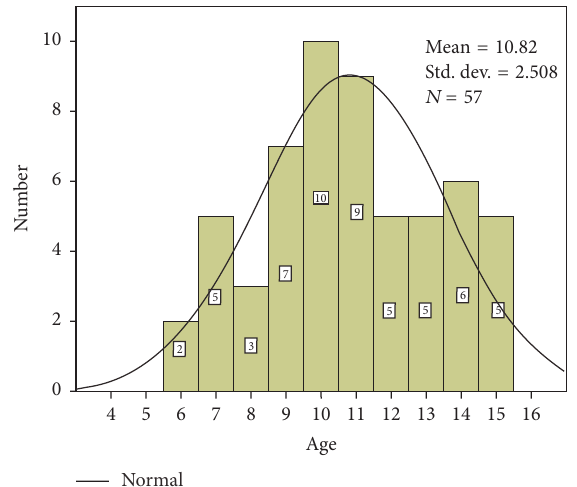
Figure 1: Distribution of patients according to the age.